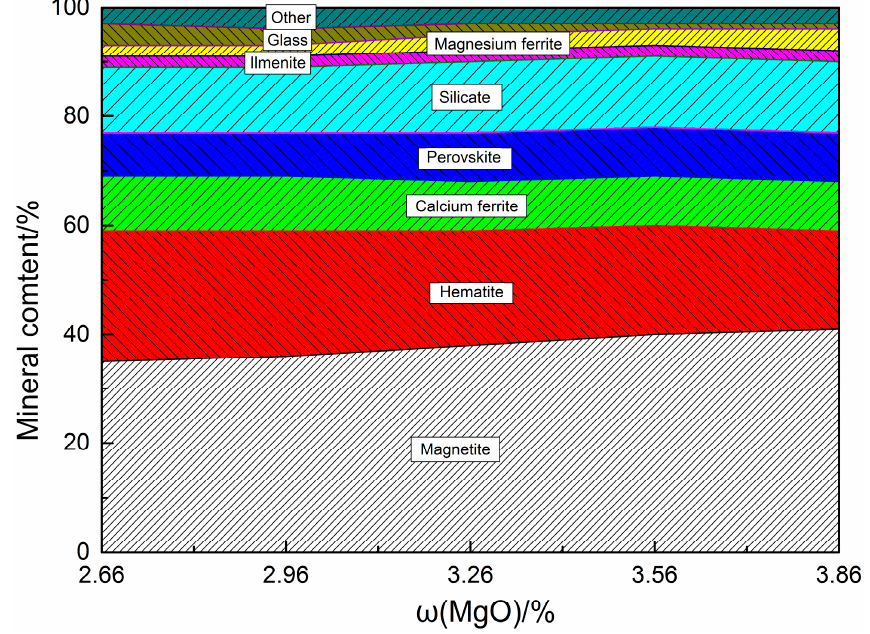
Figure 6. Mineral compositions of the CCVTM sinter with various MgO concentrations.